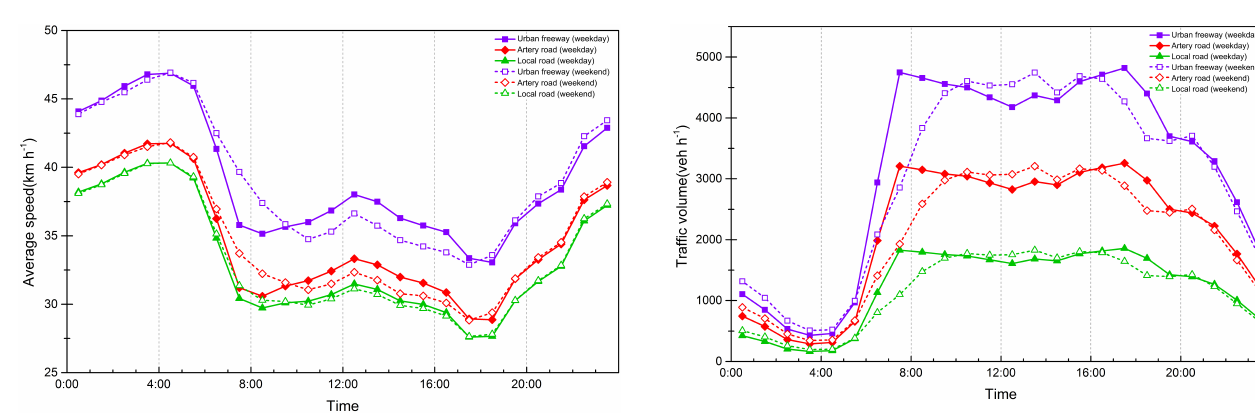
Figure 3. Hourly traffic average speed on different road types in Beijing.